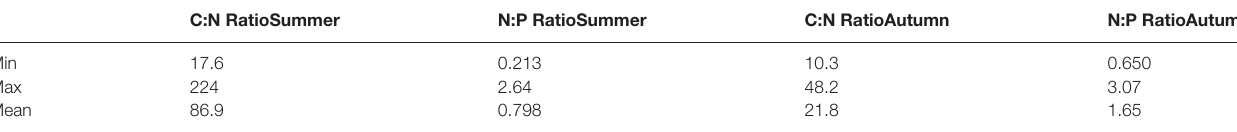
Table 3 | Molar ratios of C, N and P derived from simultaneous observations during deployment periods.